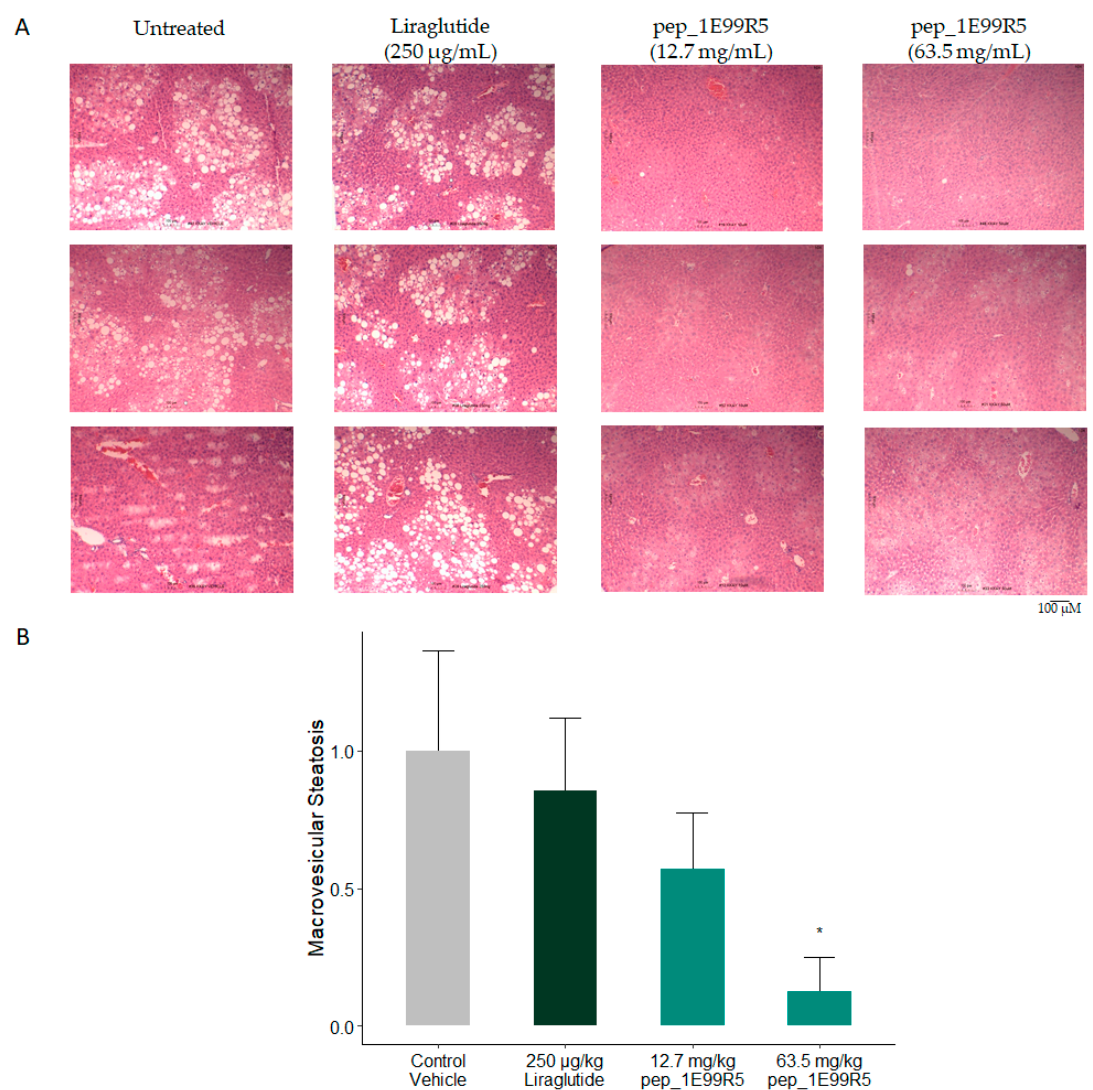
Figure 5. Effect of pep_1E99R5 on hepatic steatosis. ( A ) Livers of all mice were excised and sectioned before staining with H&E. Images were taken using a Motic BA310E trinocular compound microscope at 10x magnification. Histological non-alcohol fatty liver disease (NAFLD) scoring was performed by an independent third-party reviewer. ( B ) Features were scored according to a murine liver scoring system devised by Liang et al., 2014. Data are mean ± SEM ( n = 6 per group; aged 12 weeks at baseline) and analysed by Dunnett’s test to compare the differences between the two peptide treatment groups and vehicle control and Liraglutide groups (* p < 0.05).